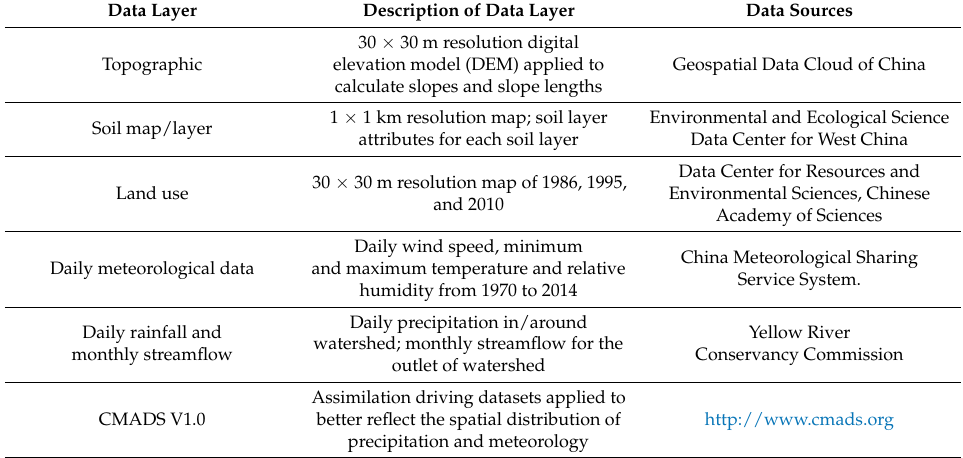
Table 1. Summarized information on the data used for this study. CMADS: China Meteorological Assimilation Driving Datasets for the Soil Water Assessment Tool